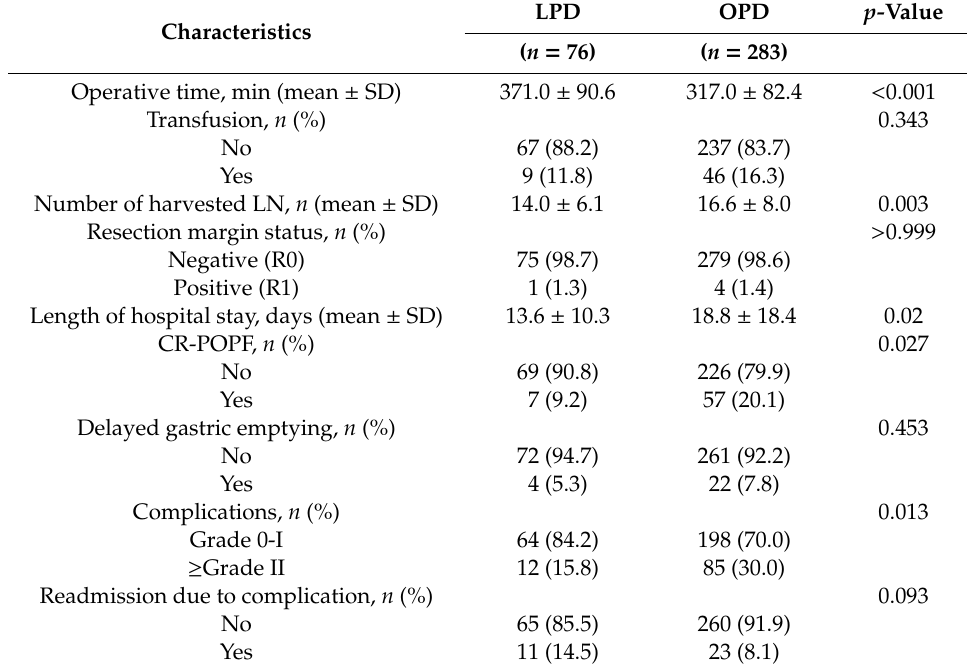
Table 3. Perioperative outcomes of all unmatched patients who underwent laparoscopic pancreaticoduodenectomy (LPD) or open pancreaticoduodenectomy (OPD). Characteristics